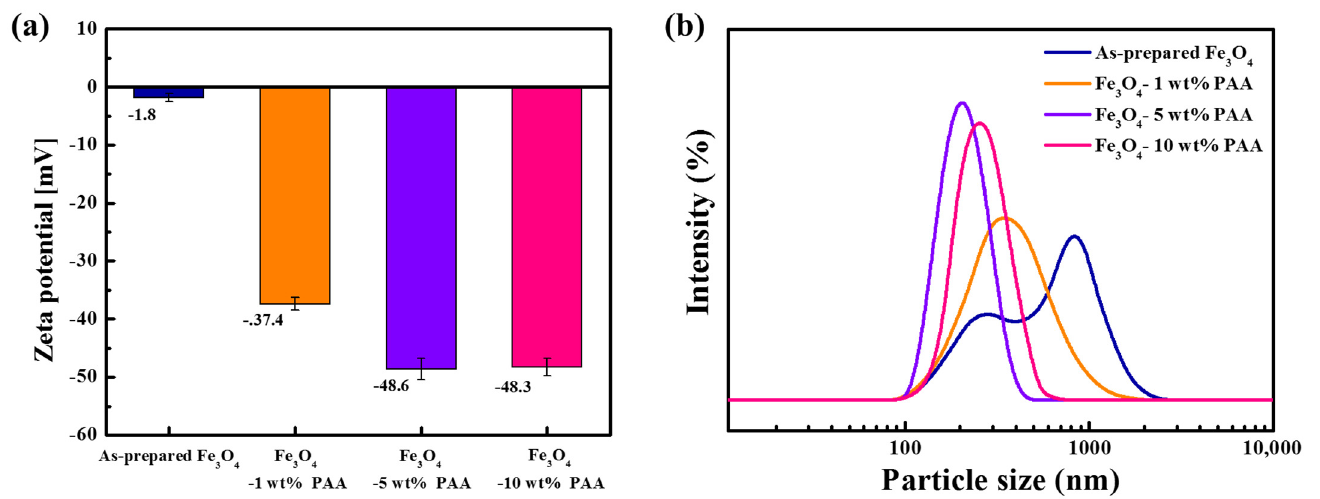
Figure 2. ( a ) Zeta potentials; ( b ) PSDs of as-prepared Fe 3 O 4 and Fe 3 O 4 modified using 1, 5, and 10 wt % PAA.